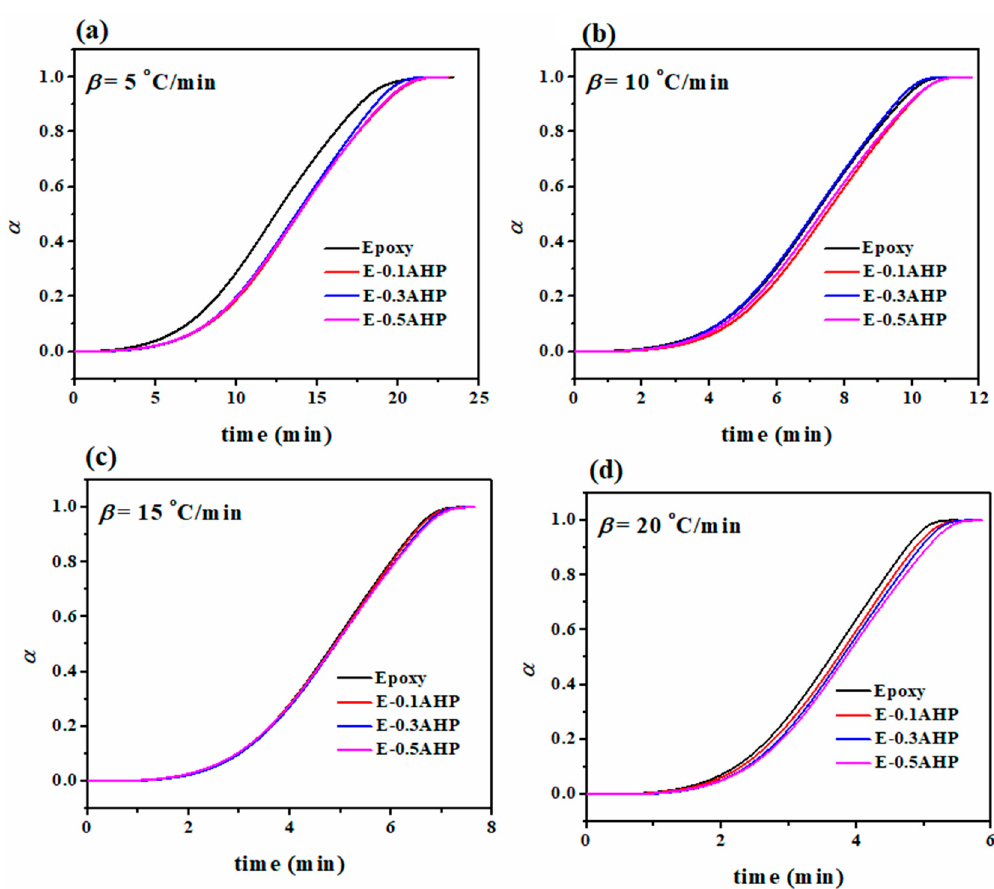
Figure 5. Fractional extent of conversion vs. time for epoxy and AHP / epoxy nanocomposites at heating rates of ( a ) 5, ( b ) 10, ( c ) 15 and ( d ) 20 °C/min.